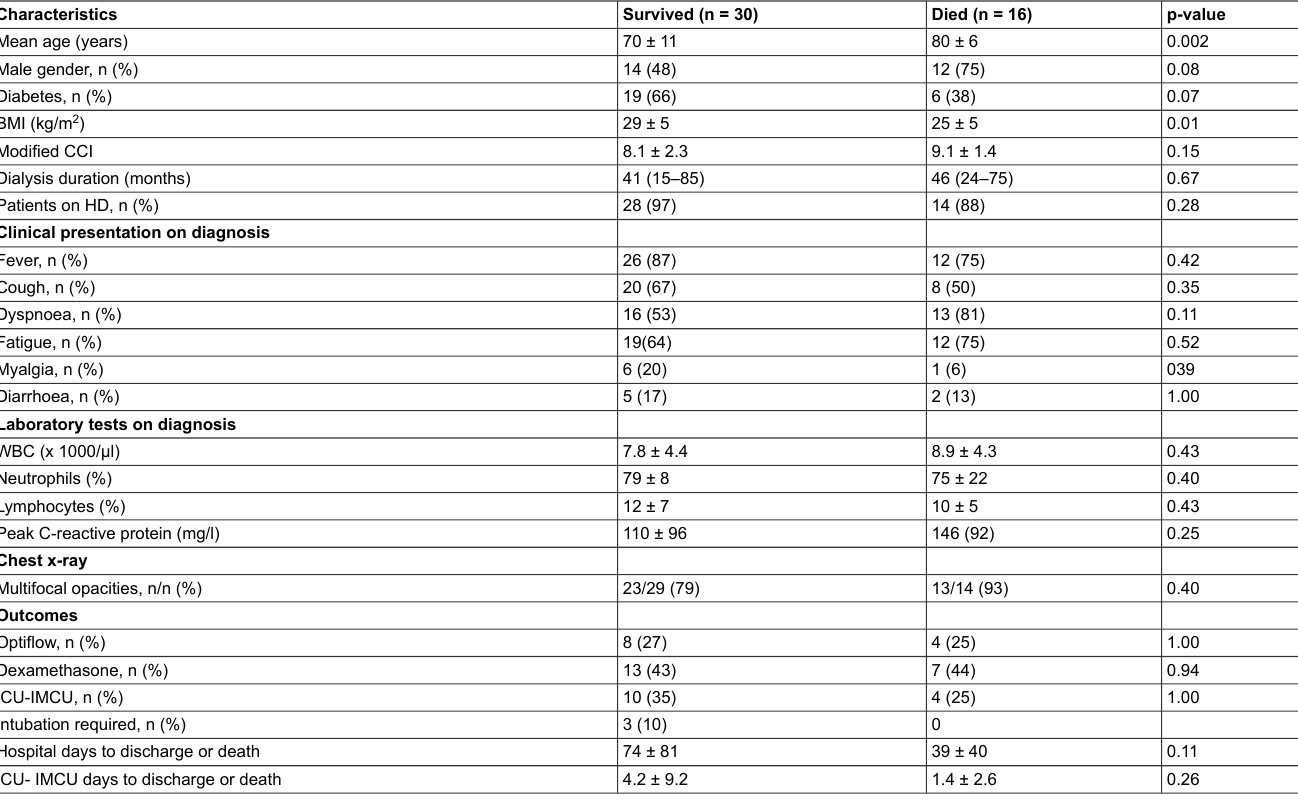
Table 2: Characteristics of hospitalised patients on maintenance dialysis with SARS CoV-2 pneumonia by outcome (Geneva area March–December 2020). Characteristics